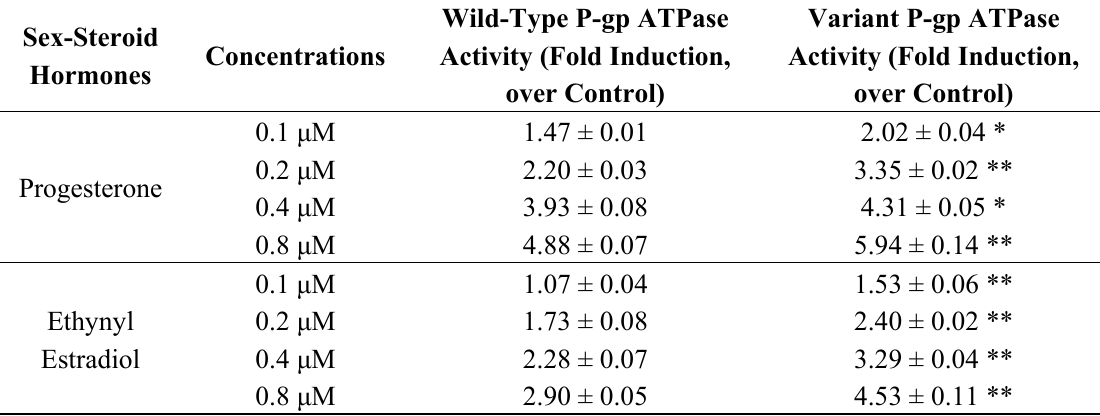
Table 3. ATPase activity of ABCB1 (1199G) or ABCB1 (1199A) P-gp after induction with ethynyl estradiol or